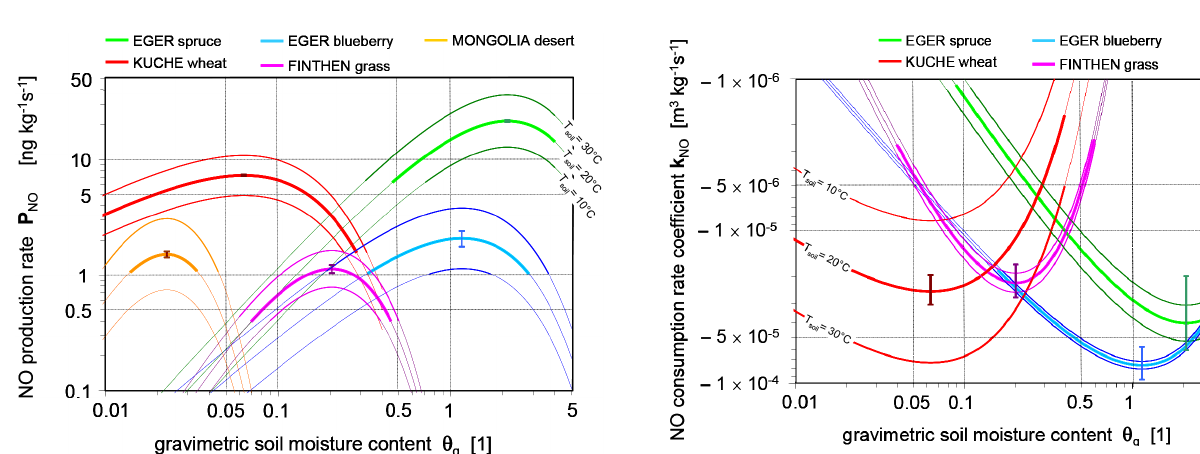
Figure 19. Summary of NO production rate ( P NO ) results of the five soil samples in this study. The curves have been calculated using the P NO (θ 0 , T 0 ), θ 0 , θ g,1 , and Q 10_P , NO data listed in Table 2. Thick solid lines represent conditions at T soil = 20 ◦ C, thinner solid lines above and below conditions of T soil = 10 ◦ C and T soil = 30 ◦ C, re- spectively. Solid lines cover the range of those values which have passed corresponding rejection criterion ( = minimum detectable P NO , see Sect. 5.2). Error bars of P NO (θ 0 , T 0 ) are from Table 2 and indicate respective optimum gravimetric soil moisture contents ( θ 0 ).